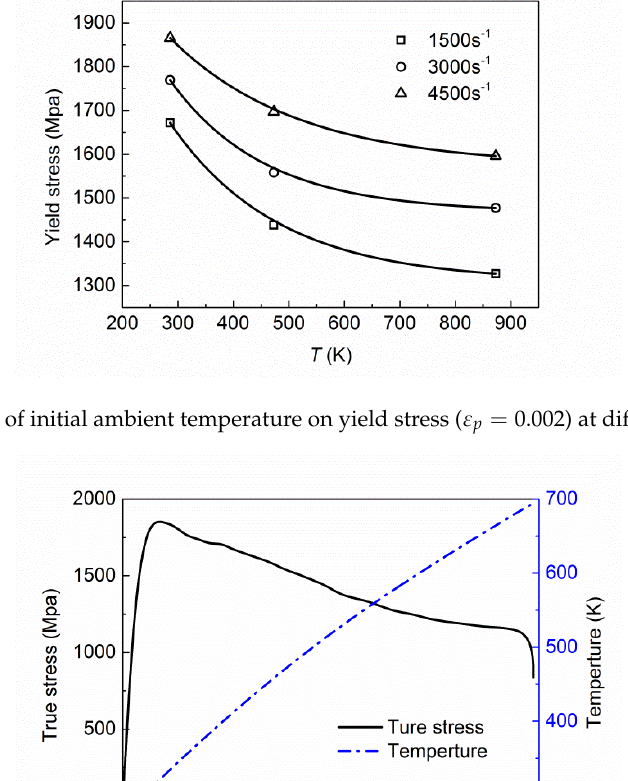
Figure 12. Deformation temperature rise of Mo-10Ta (286 K, 4500 s −1 ).